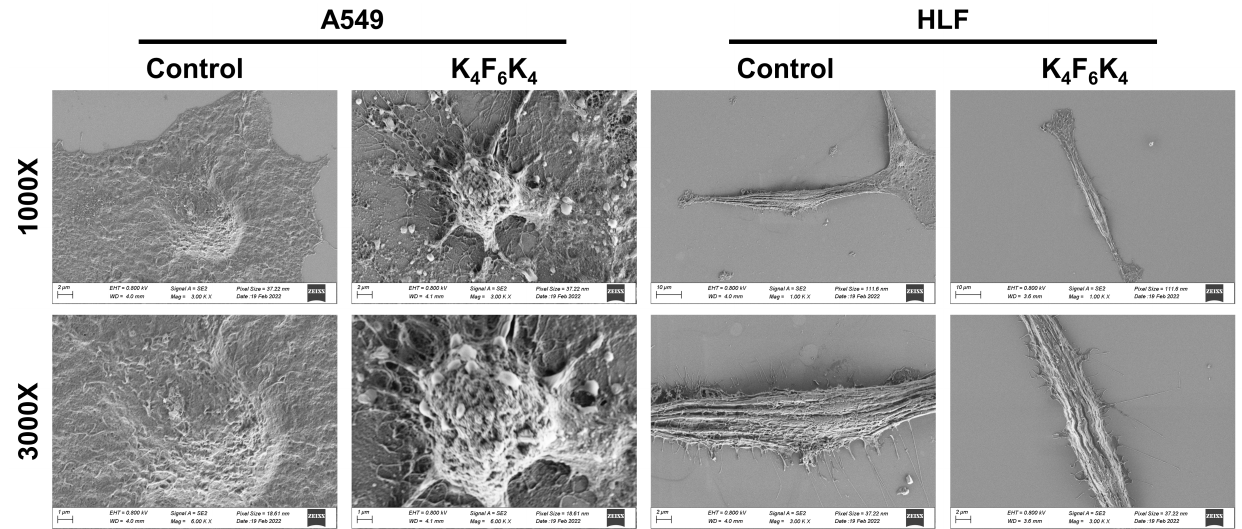
Figure 6. SEM images of the A549 and HLF cells treated with K 4 F 6 K 4 for 12 h. Magnifications were 1000 × and 3000 × .